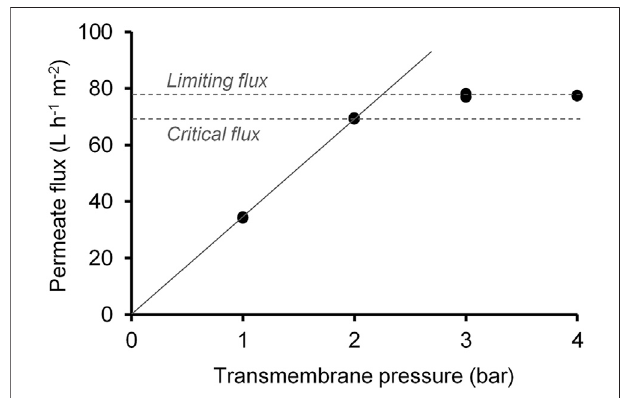
FIGURE 4 | In fl uence of transmembrane pressure on permeate fl ux and determination of critical and limiting permeate fl